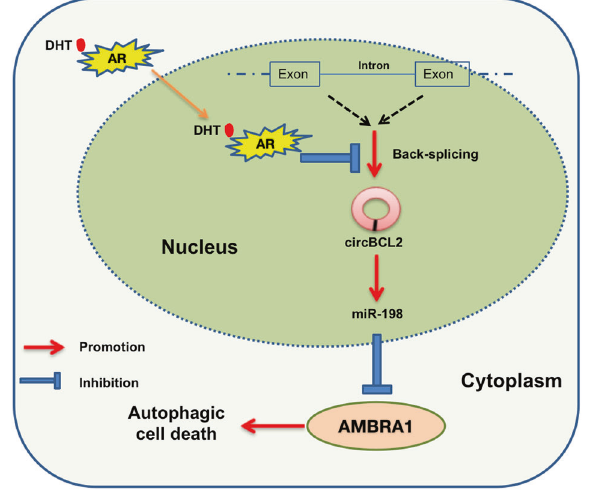
Fig. 7 A mechanistic diagram. A mechanistic diagram for DHT effect in CRPC